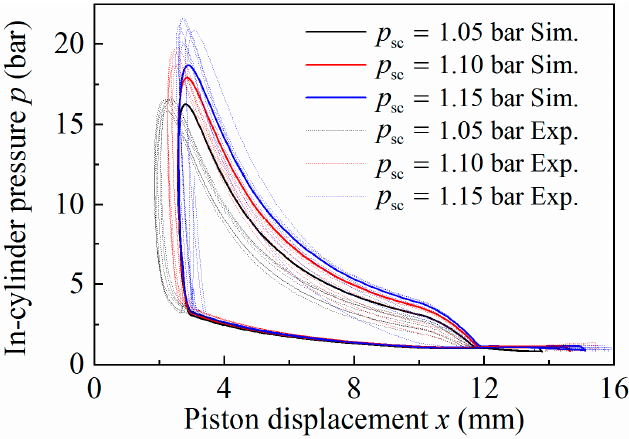
Figure 6. Model validation against the measured in-cylinder gas pressure.